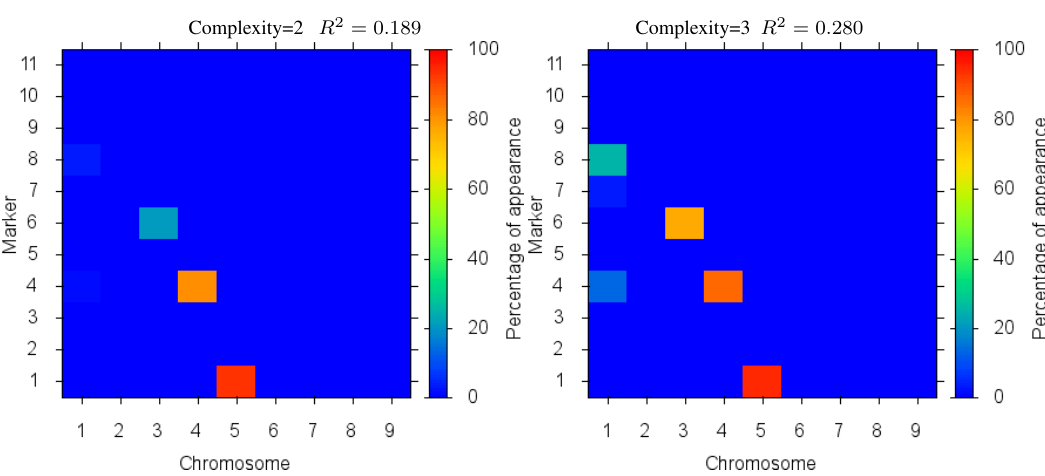
Figure 6. Case II Markers Identified: in different complexity Pareto optimal solutions for Case II. The color is the proportion of random executions that the specific marker was found. Bright red signifies that in each run the marker was consistently found. Blue means that the marker did not appear in any